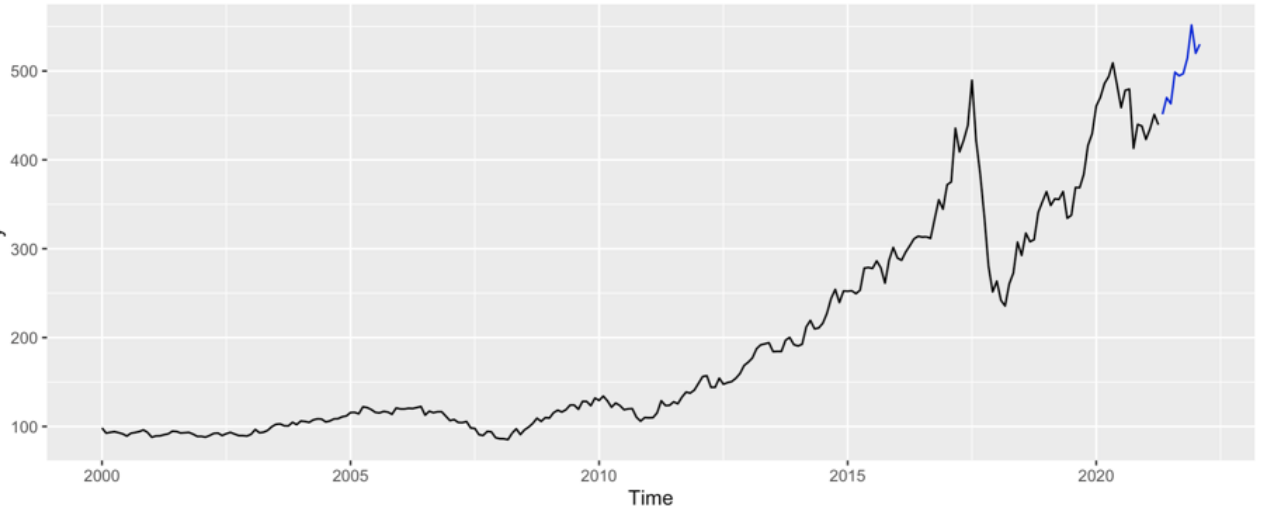
Figure 5. Forecast after the COVID-19 structural break in the commodity index.